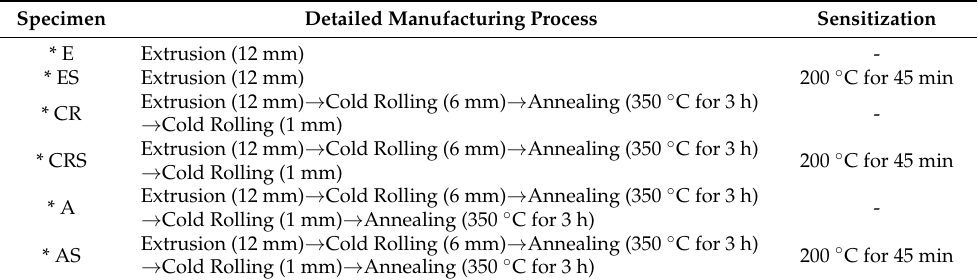
Table 1. Detailed manufacturing process of new Al-6Mg alloy. Specimen Detailed Manufacturing